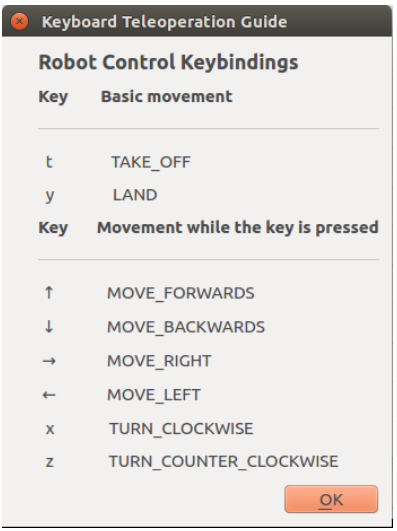
Figure 9. Available commands for tele-operation using the keyboard.